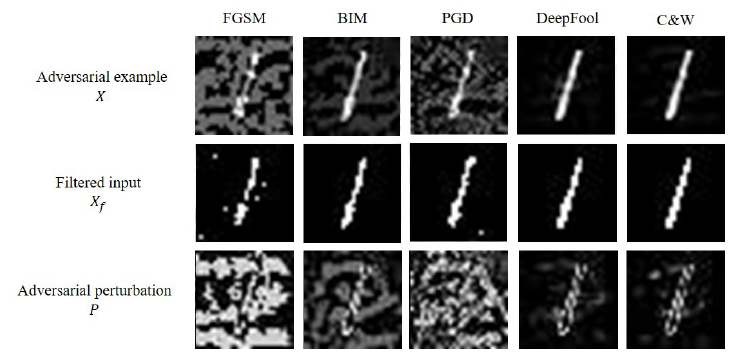
Figure 3. Five extracted adversarial perturbation from adversarial examples in MNIST test dataset, where each perturbation is denoised using a binary filter.